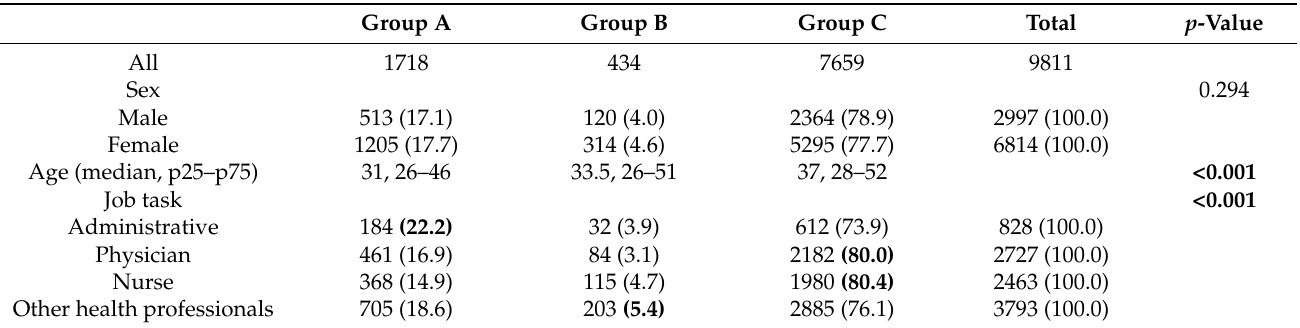
Table 1. Demographic and occupational characteristics of 9811 health workers by SARS-CoV-2